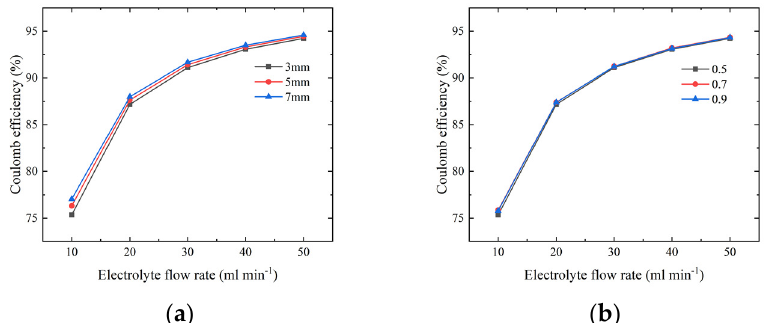
Figure 14. Coulomb e ffi ciency of ba tt ery with ( a ) di ff erent electrolyte fl ow rates and electrode thick-